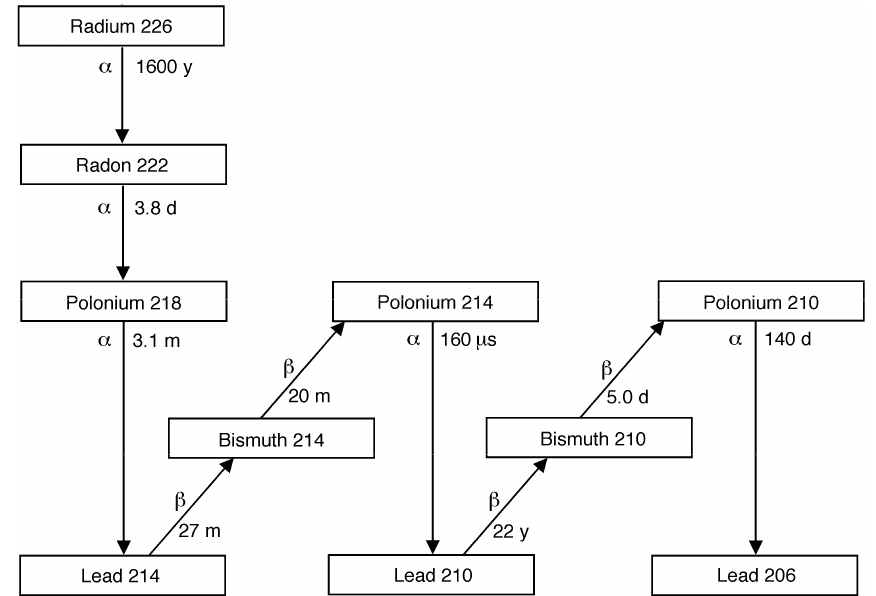
Fig. 1. The Basic Radon ( 222 Rn) Decay Chain. The isotopes and their atomic masses are shown within the boxes; the main decay processes are indicated by arrows, with type of decay and half-life